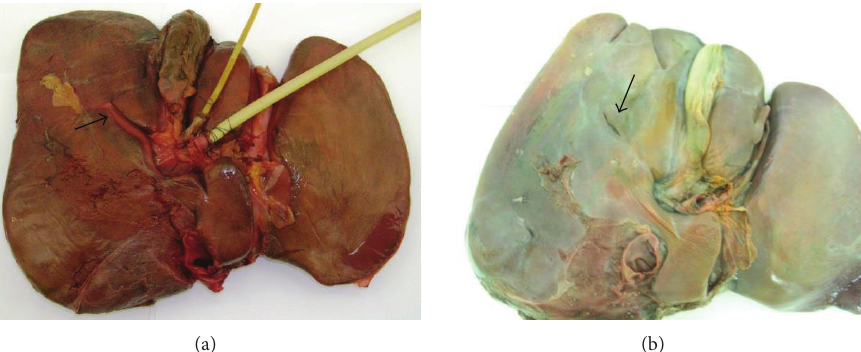
Figure 1: (a) Open type of Rouviere’s sulcus with visible right portal pedicle. (b) Partially fused Rouviere’s sulcus open at its lateral end.